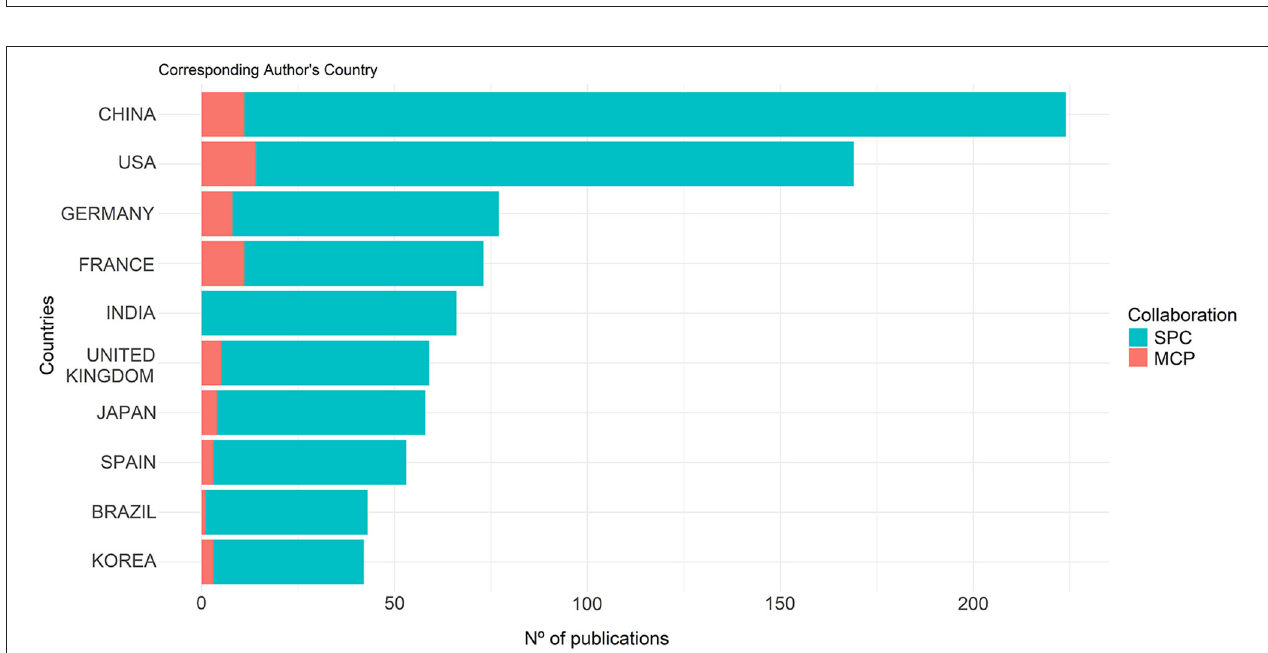
FIGURE 3 | Single and multiple countries’ publications on microalgae-fungi consortia.